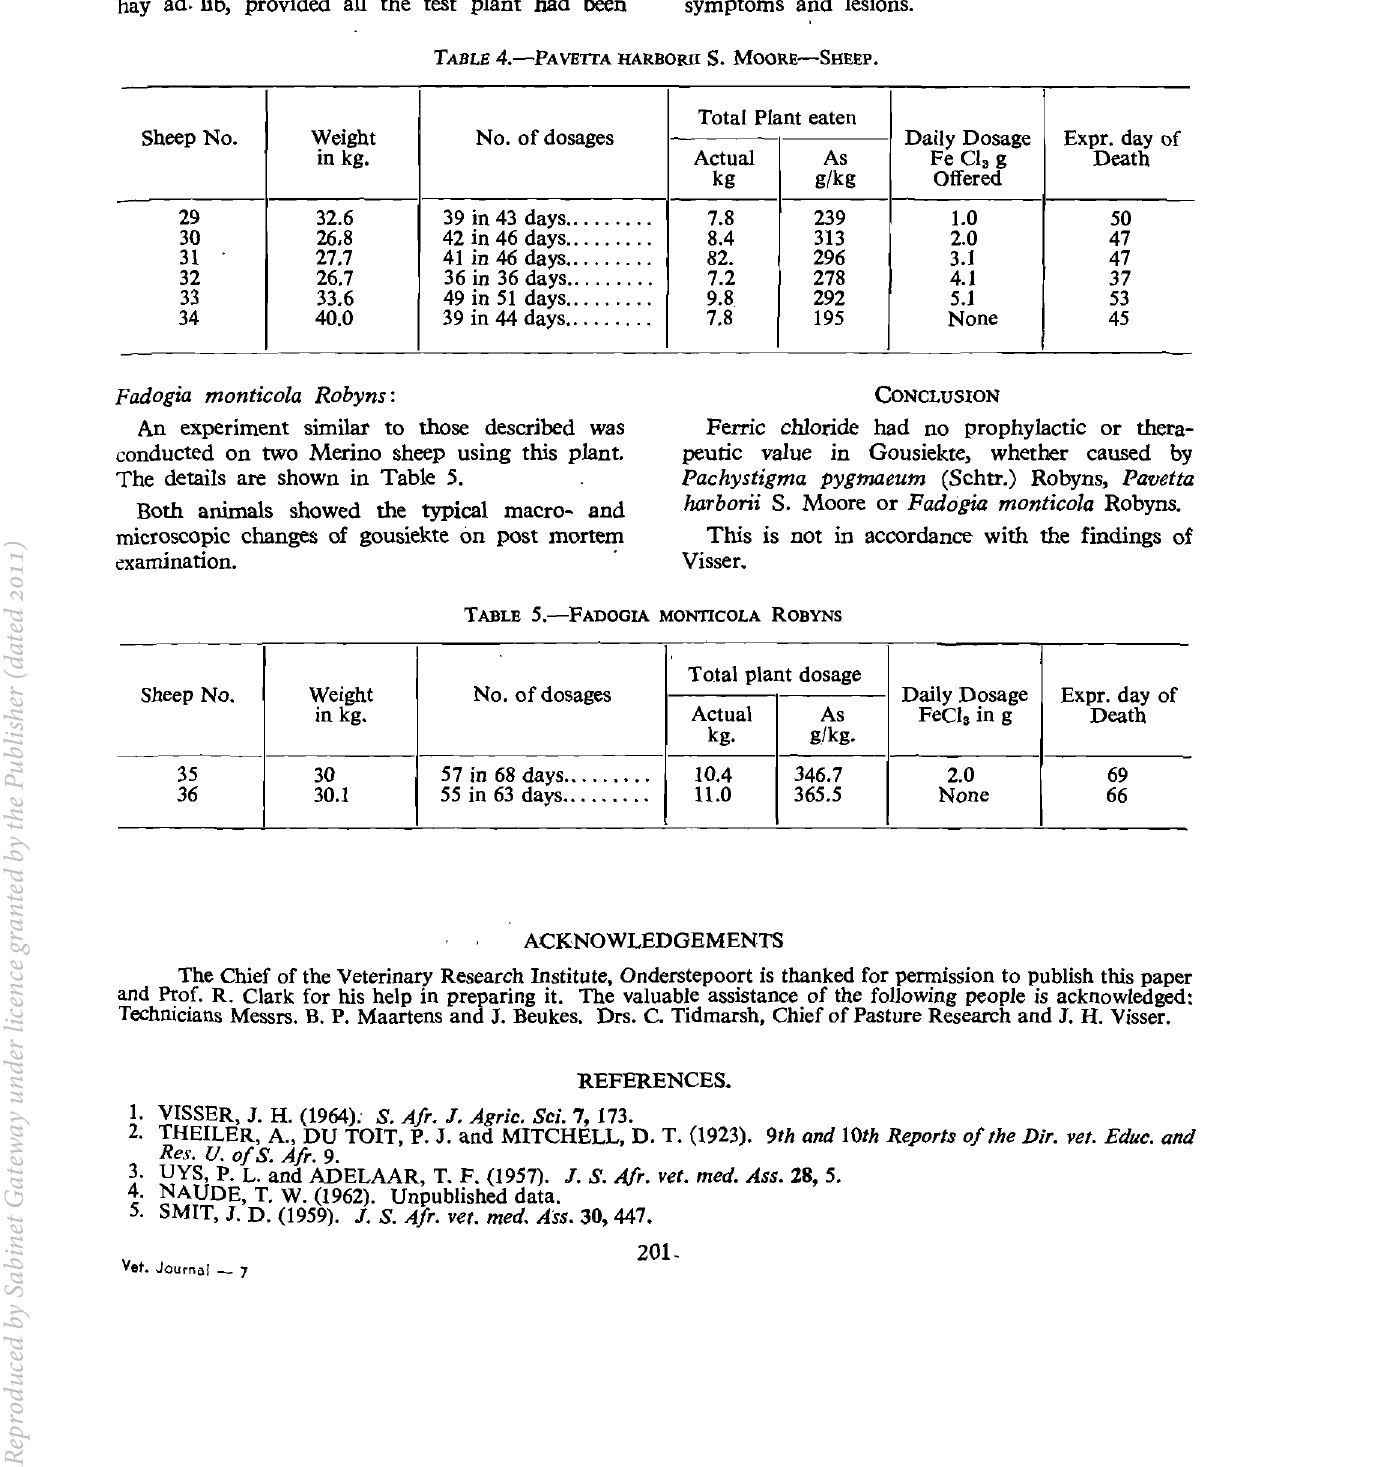
Table 4. The 6th sheep served as a control. Of this they consumed 1 to 2 litres daily. The actual